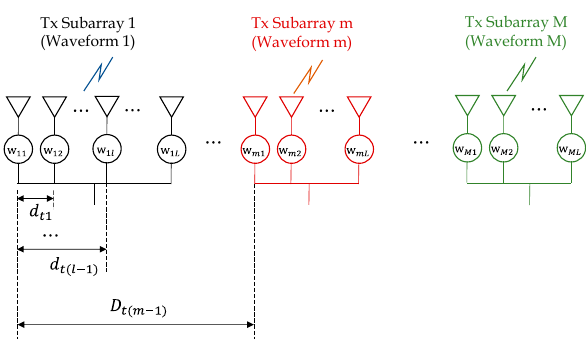
Figure 1. Configuration of the transmit antenna with subarrays.